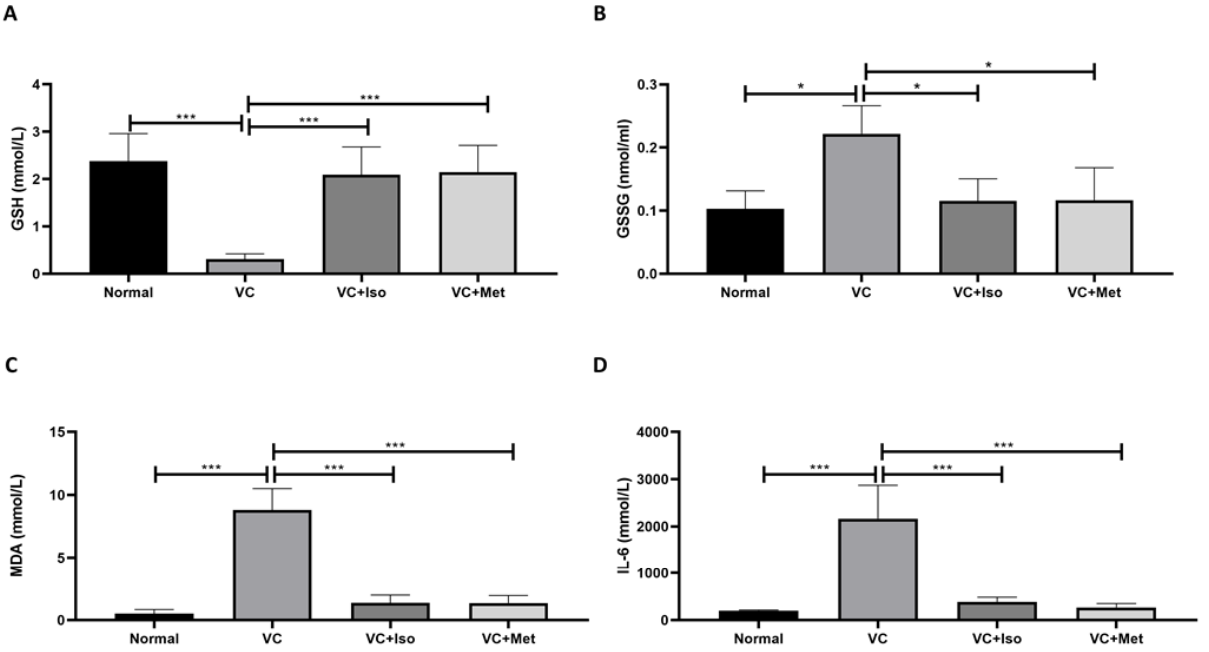
Figure 6. The anti-inflammatory effect of isorhamnetin. Isorhamnetin significantly increased GSH ( A ), and reduced GSSG ( B ), MDA ( C ), and IL-6 ( D ) levels in diabetic mice. Mice were fed with HFD for 8 weeks followed by two low doses of STZ injection (40 mg/kg) after diabetes confirmed, mice were treated with 10 mg/kg isorhamnetin or 200 mg/kg metformin for 10 days, mice were then sacrificed, and serum collected for ELISA analysis. One-way ANOVA followed by Tukey post hoc, * <0.05, *** <0.001. VC; vehicle control, Iso; isorhamnetin, Met; metformin.